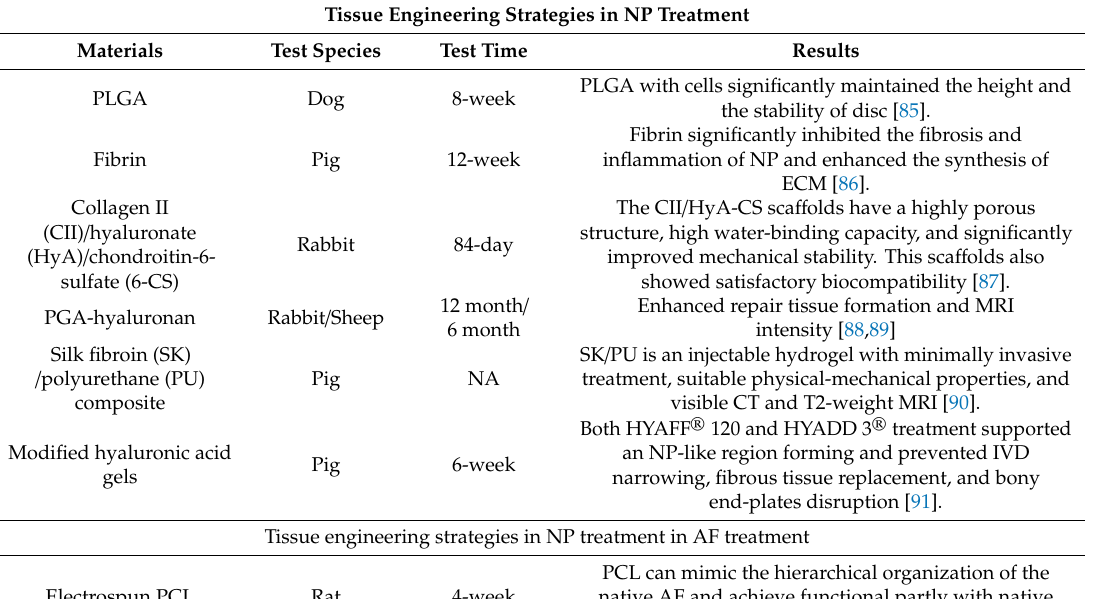
Table 2. Summary of tissue engineering strategies in intervertebral disc degeneration (IDD)